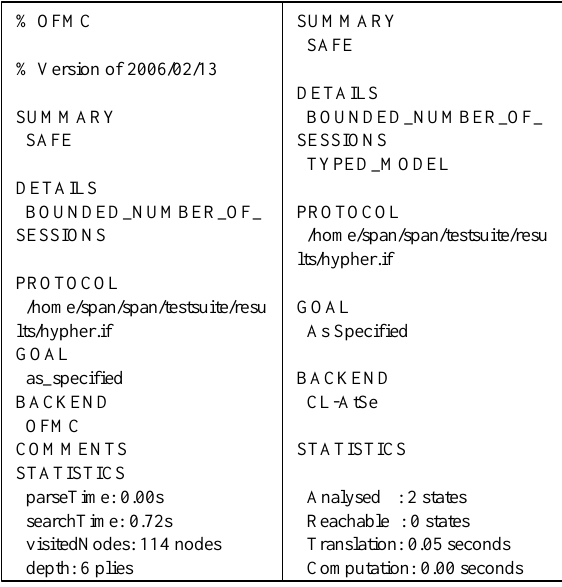
Figure 10. Result of Automated Validation of Internet Security Protocols and Applications (AVISPA) simulation using On-the-fly Model-Checker (OFMC) and CL-based Attack Searcher (CL-AtSe)